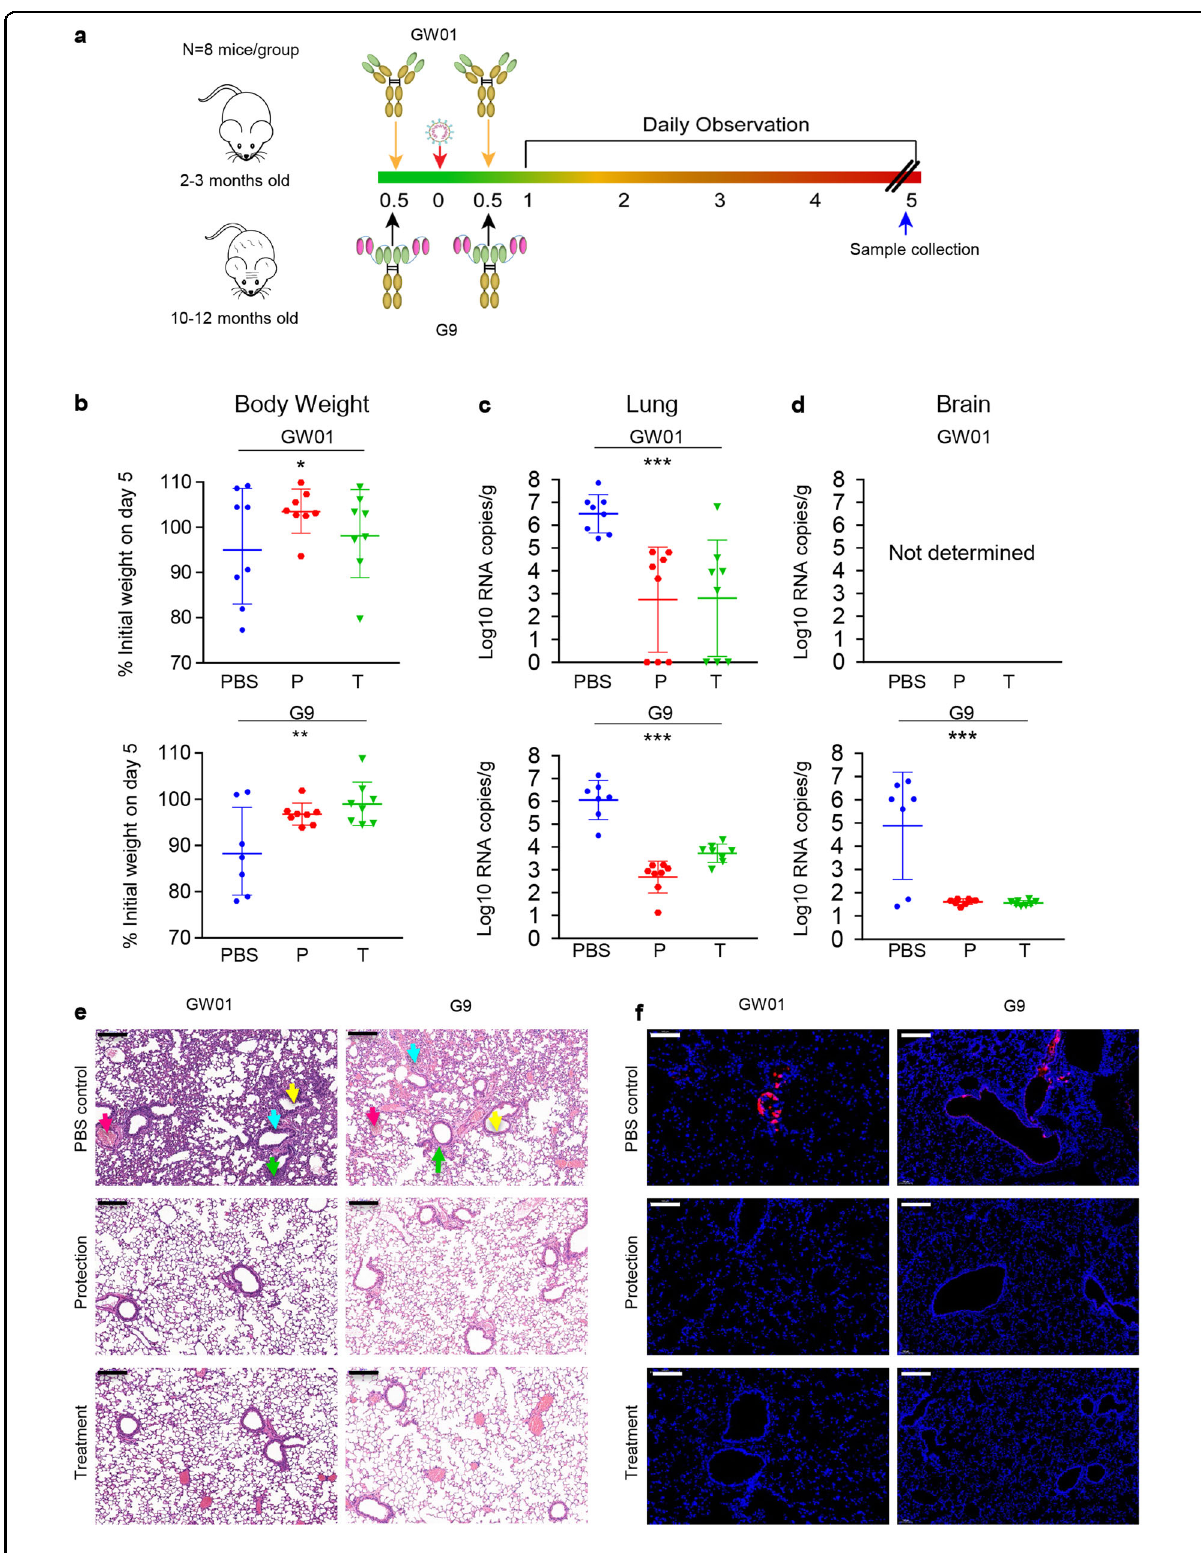
Fig. 5 (See legend on next